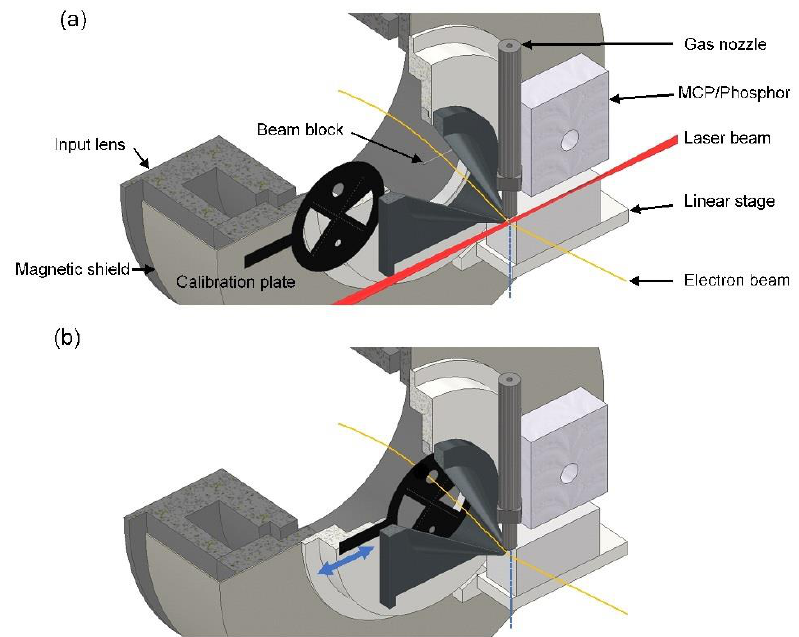
Figure 2. ( a ) An expanded view around the scattering point where the electron beam (yellow), the laser beam (red), and the atomic/molecular beam (blue broke line) cross at right angles. The scat- tered electrons are introduced into the ARTOF tube through the tip hole (14 mm ϕ ) of the entrance skimmer. ( b ) An expanded view around the scattering point when the calibration plate is inserted for the angular calibration of the electron scattering signals.